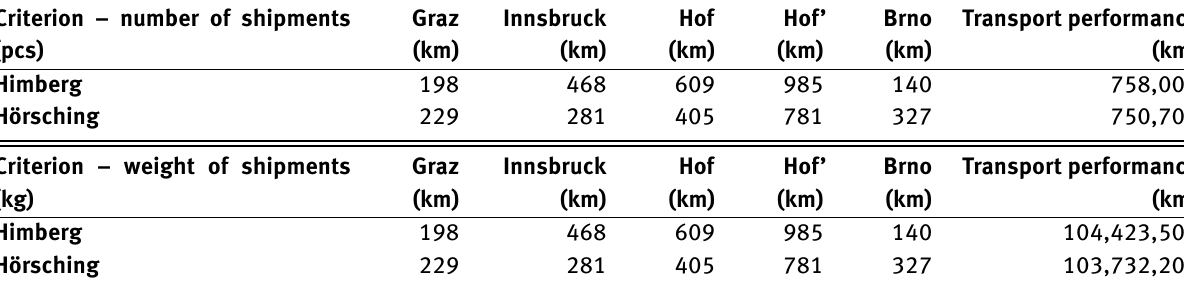
Table 3: Outcome of the location problem